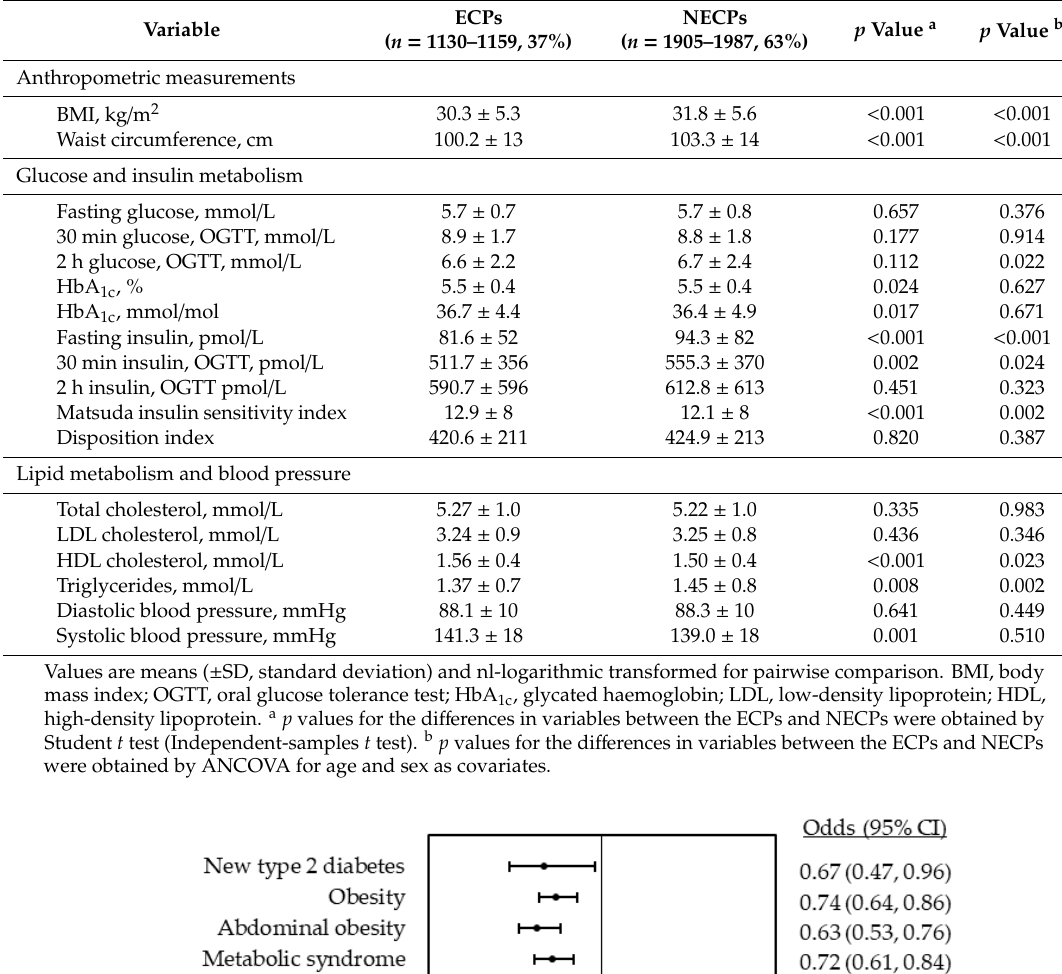
Table 3. Metabolic risk factors for type 2 diabetes in eating competent participants (ECPs) ( ≥ 32 points) and not eating competent participants (NECPs) ( < 32 points).